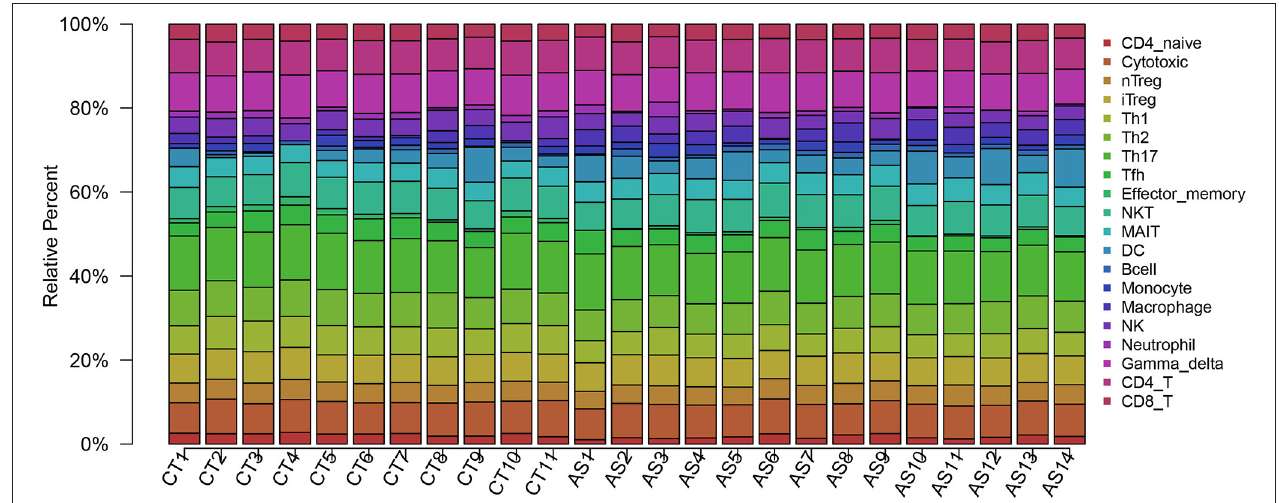
FIGURE 1 | A bar plot of immune infiltration in normal samples and atherosclerosis samples. About 22 subpopulations of immune cells in 25 carotid artery samples [11 normal tissues (CT) and 14 atherosclerotic tissues (AS)] are